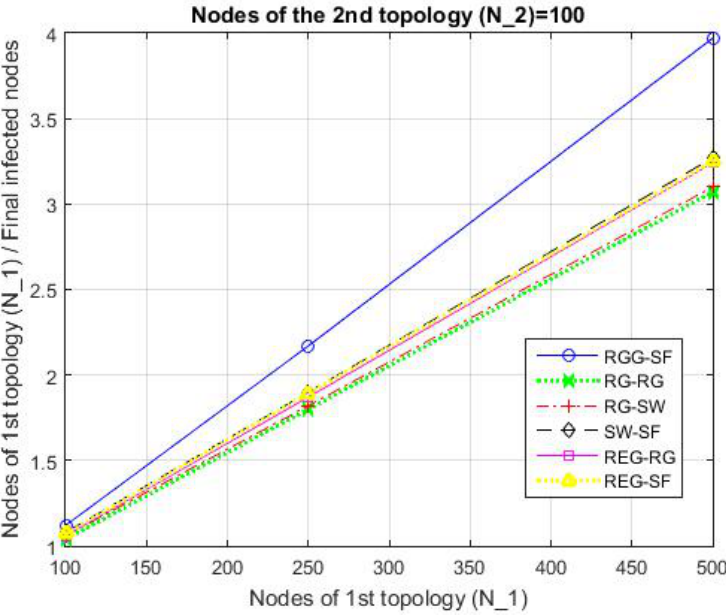
Figure 11. Spread of malware while the nodes of the 2nd topology remain equal to N_1 = 100.